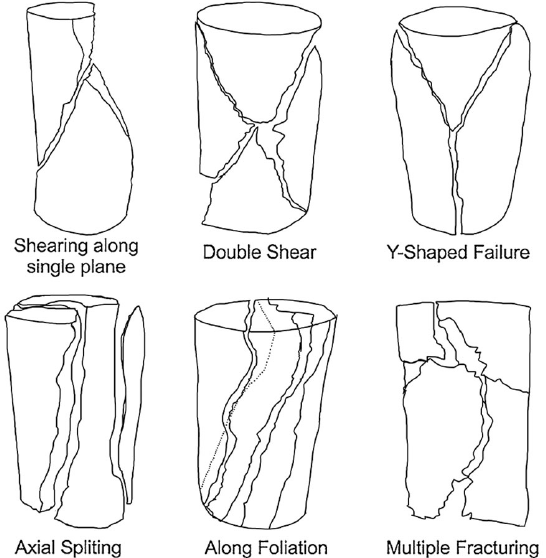
Figure 4. Schematic representation of different failure modes under uniaxial compression